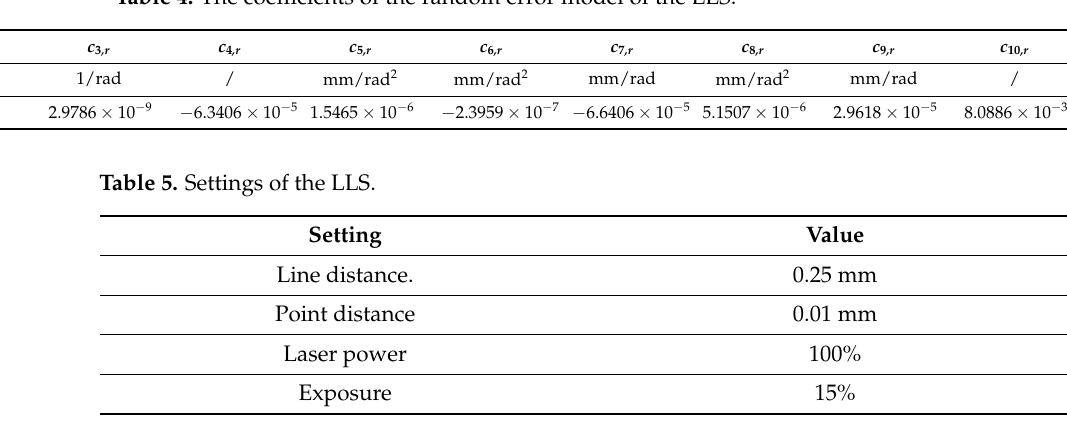
Table 4. The coefficients of the random error model of the LLS.